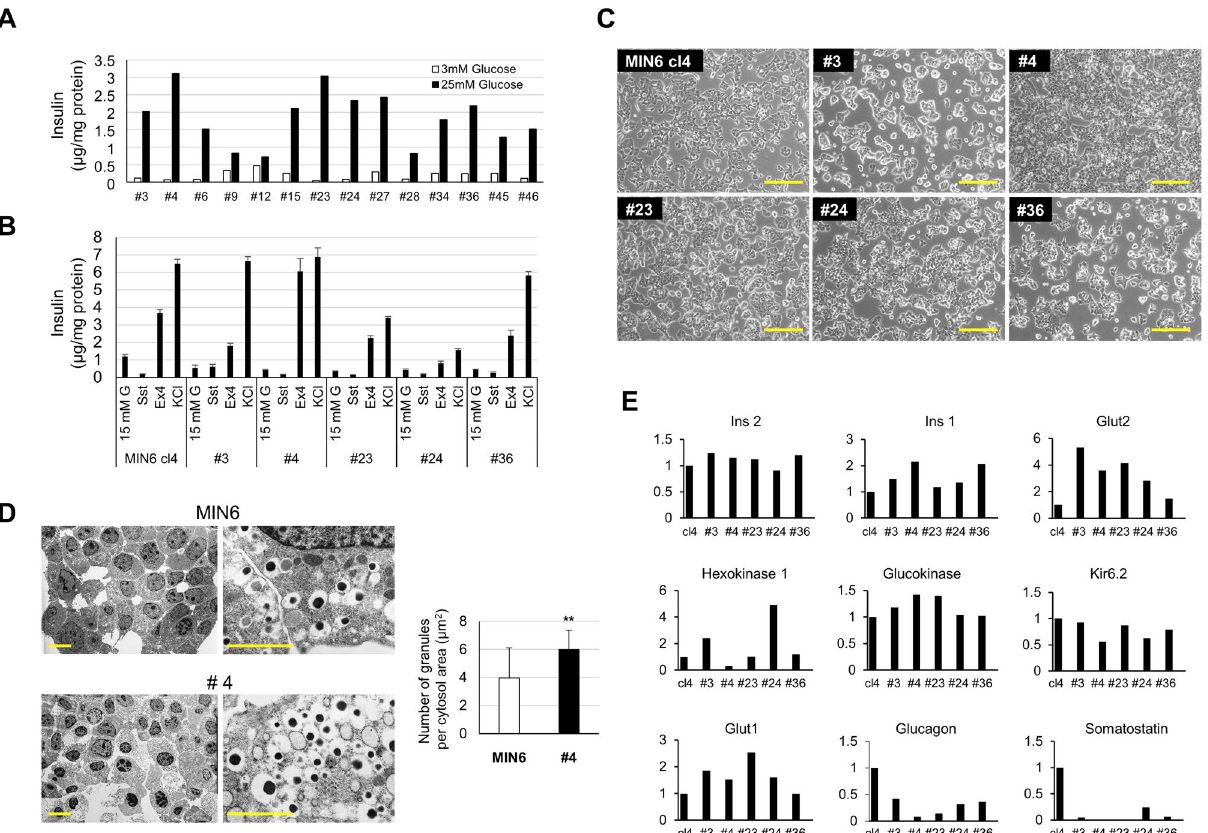
Figure 1. Stable pancreatic β-cell lines were selected from continuously cultured insulinoma cells derived from an IT6 transgenic male mouse on the C3B6F1 genetic background. ( A ) Insulin secretion of MIN6-CB cell lines stimulated with 3 or 25 mM glucose. Values represent means (n = 2). Five CB cell lines (#3, #4, #23, #24, and #36) were selected which showed proper GSIS after long-term culture. ( B ) Insulin secretion of MIN6-cl4 and CB cell lines (#3, #4, #23, #24, and #36) stimulated with 15 mM glucose alone or with somatostatin (Sst; 10 nM), exendin-4 (Ex4; 20 nM), or KCl (30 mM). Values represent means ± S.D. (n = 3). ( C ) Phase-contrast micrographs of MIN6-cl4 and CB cell lines (#3, #4, #23, #24, and #36). Some cell lines (cl4, CB24, and CB36) show neurite- like structures. Scale bars, 200 μm. ( D ) Transmission electron microscopy of original MIN6 and MIN6-CB4 cells. Scale bars, 5 μm (left panels), 1 μm (right panels). The right graph shows insulin granule density in the cytoplasm of MIN6 and CB4 cells. CB4 cells include more insulin granules than MIN6 cells. Values are means ± S.D. (n = 20). ** P < 0.01 by Student’s t-test. ( E ) Quantitative RT-PCR analysis of β-cell-related genes in MIN6-cl4 and CB cell lines (#3, #4, #23, #24, and #36). Values represent means of technical